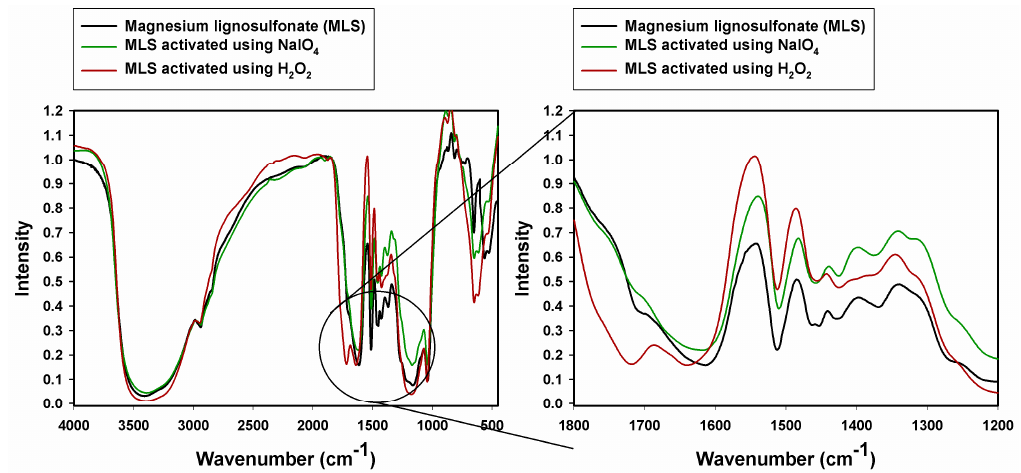
Figure 1. FTIR spectra of pure and activated magnesium lignosulfonate.